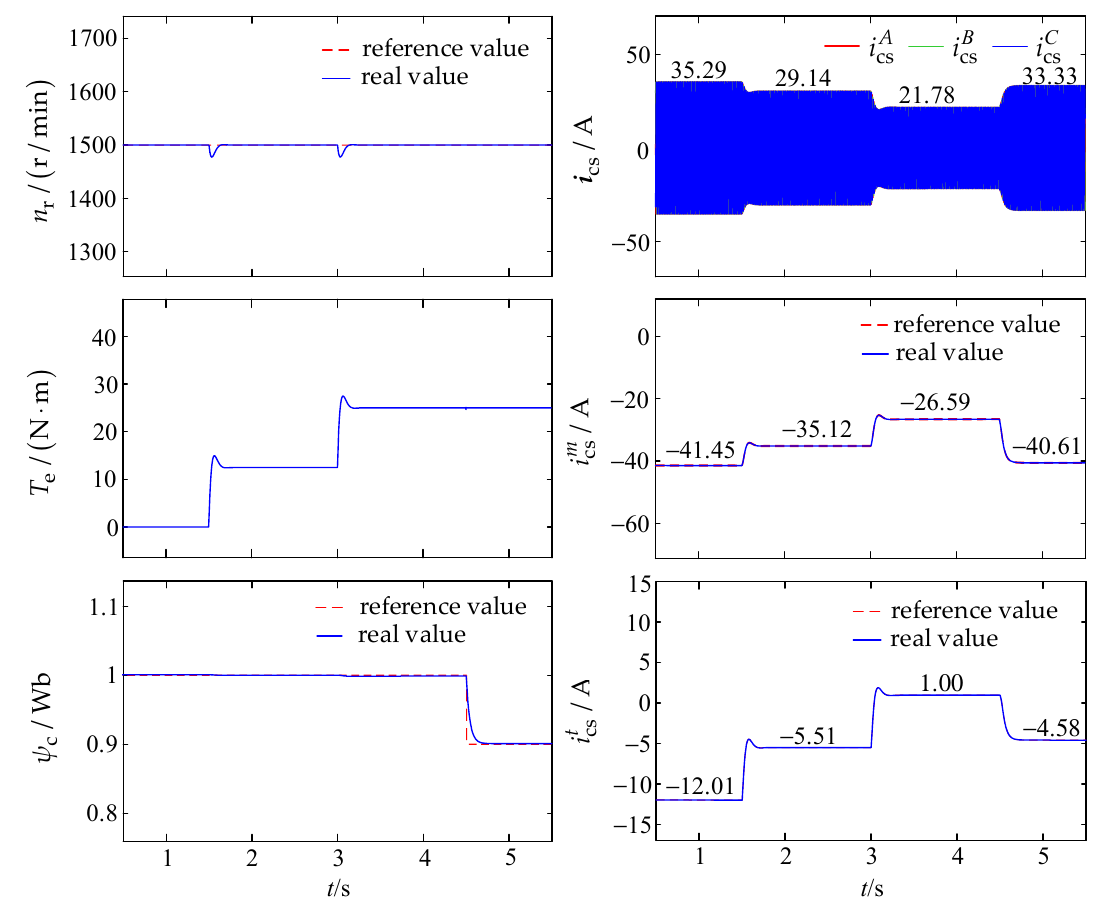
Figure 12. Simulation results of * c = constant ψ control when torque changes.